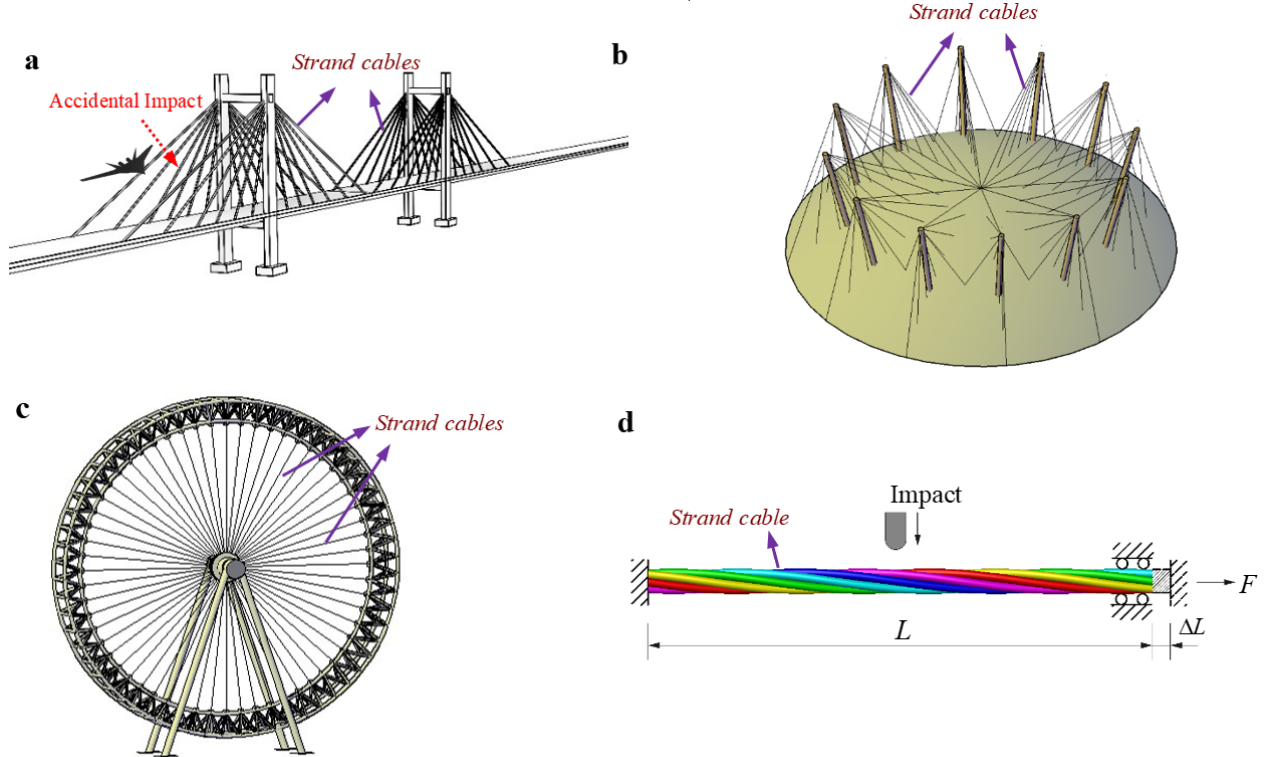
Figure 1. Background and problem schematic: ( a ) cable − stayed bridge; ( b ) large − span steel roof; ( c ) Ferris wheel; ( d ) mechanical model of strand cables under impact.